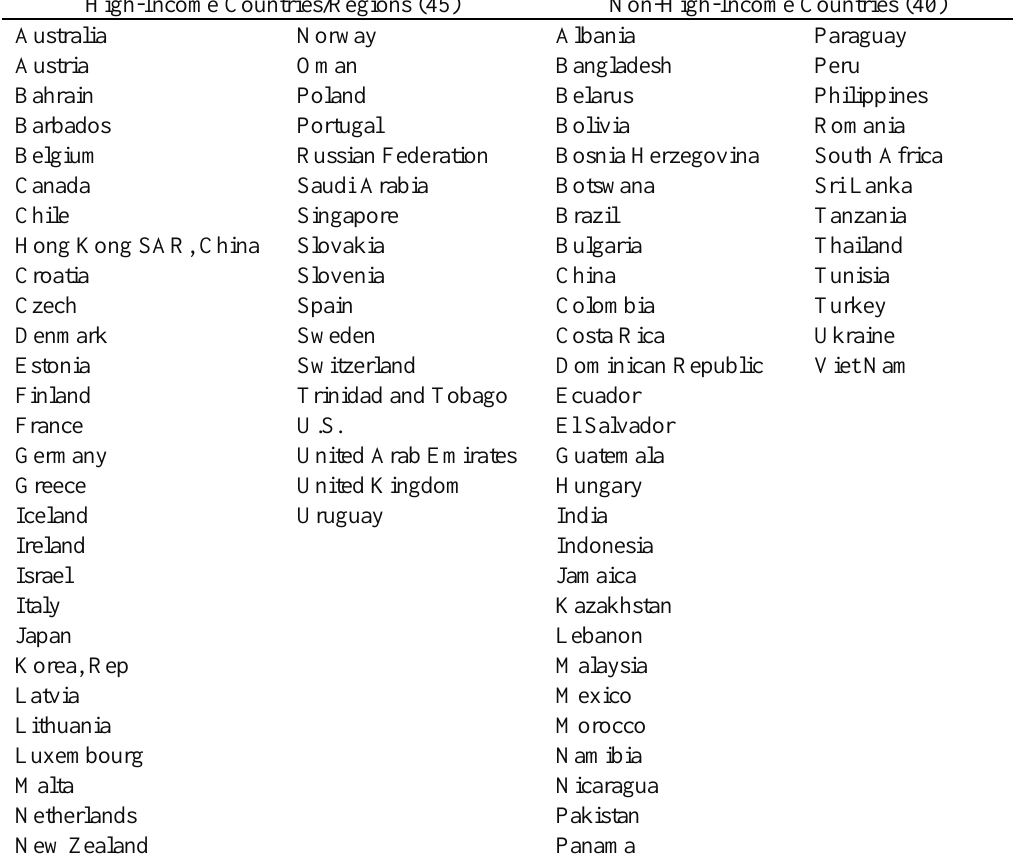
Table 1. Countries/Regions Included in the Analyses High-Income Countries/Regions